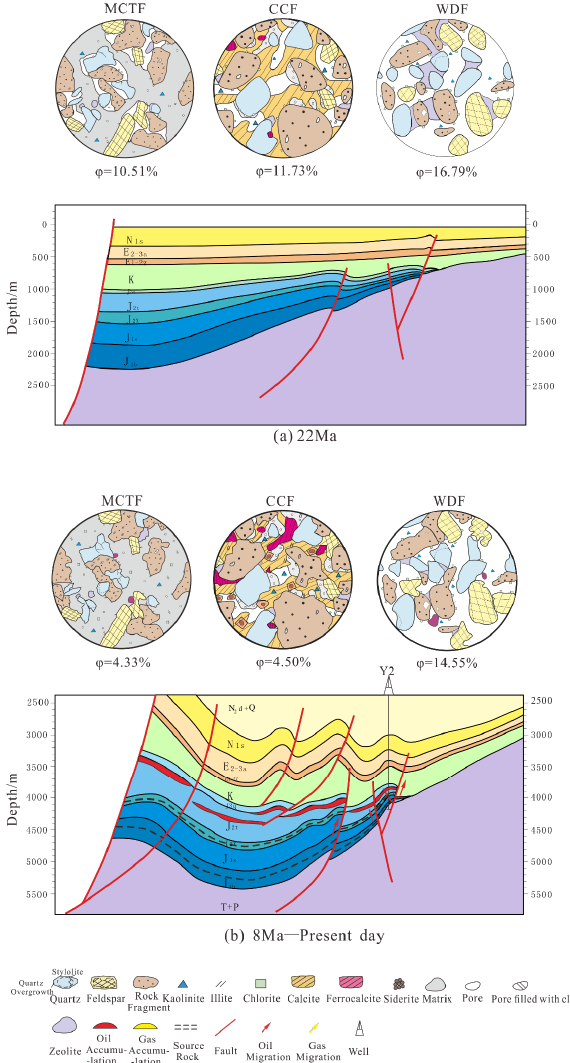
Figure 12. Reservoir-forming models of three lithofacies in the Toutunhe Formation. Tectonic evolution model of the Kayindike anticline was modified by the Xinjiang oil filed,